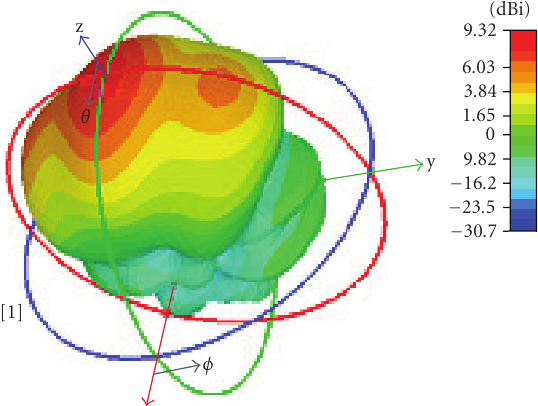
Figure 6: Directivity of the antenna placed inside the